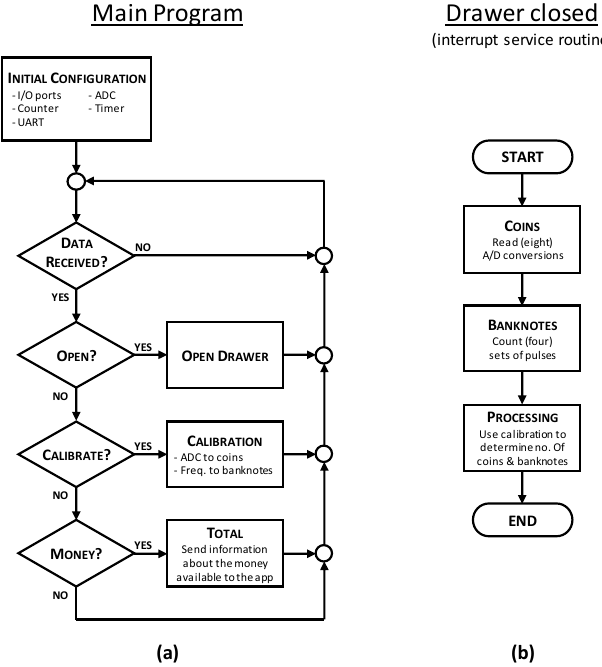
Figure 15. Flow diagram of ( a ) the main program of the microcontroller, and ( b ) the interrupt service routine associated to the cash drawer being closed.